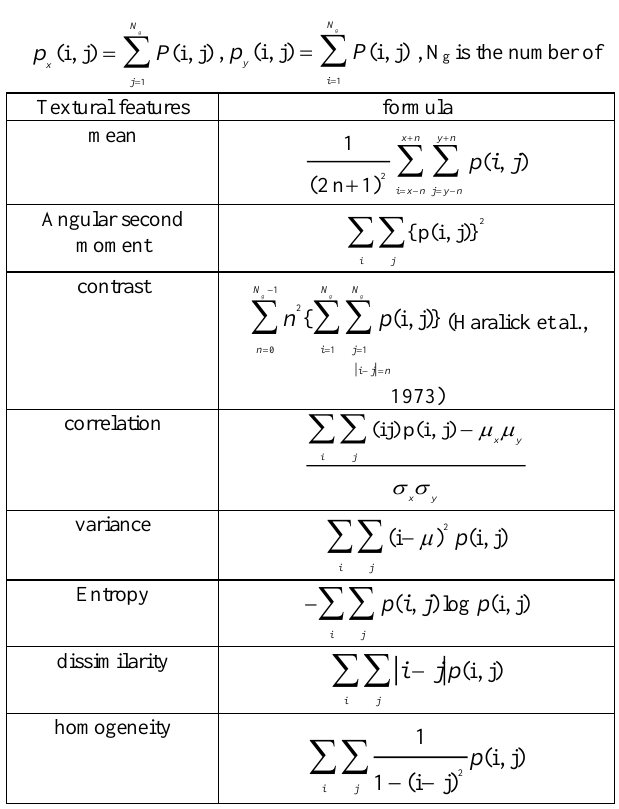
Table 1. gray level co- occurrence features used for classification